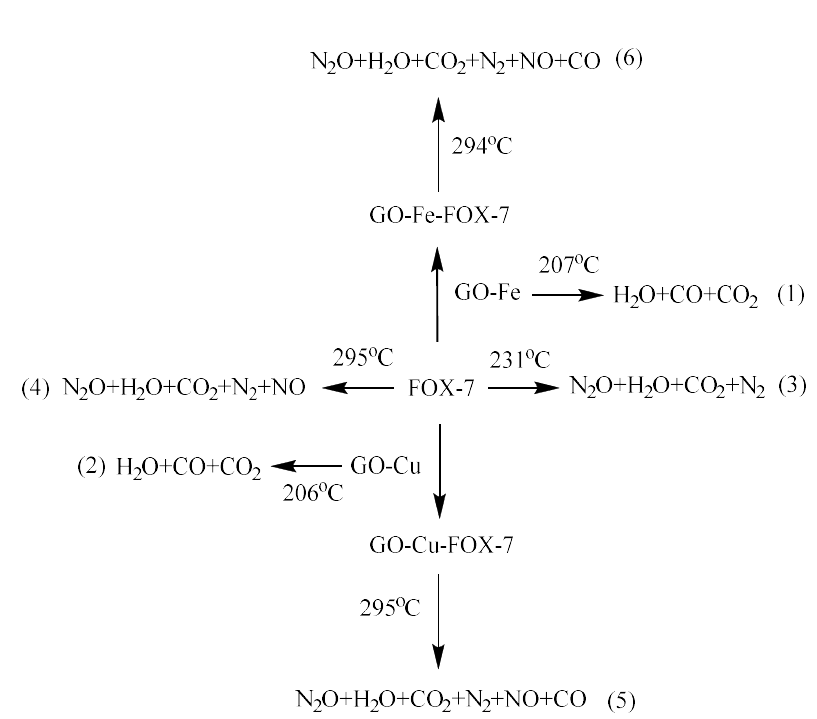
Figure: S4 Mutil-elemental EDS mapping images of nGO-Cu: (a) SEM image, the distribution of (b) C, (c) O, (d) Cu atoms, Figure: S5 Mutil-elemental EDS mapping images of nGO-Fe: (a) SEM image, the distribution of (b) C, (c) O, (d) Fe atoms, Figure: S6 The comparison of GO-Cu and GO-Fe in FTIR, Figure S7: The ion current spectra ion current